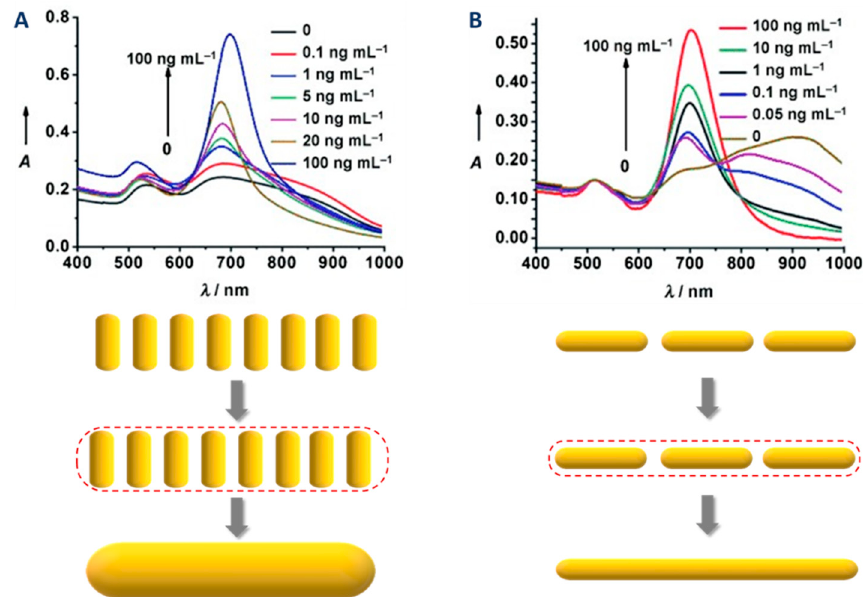
Figure 21. Evolution of surface plasmon resonance spectra of the nanorods upon increasing concentrations of microcystin-LR (indicated in the graph) and graphical representation of a plasmon system and corresponding nanowire approximation for side-to-side ( A ) and end-to-end ( B ) assemblies, from ref. [176].